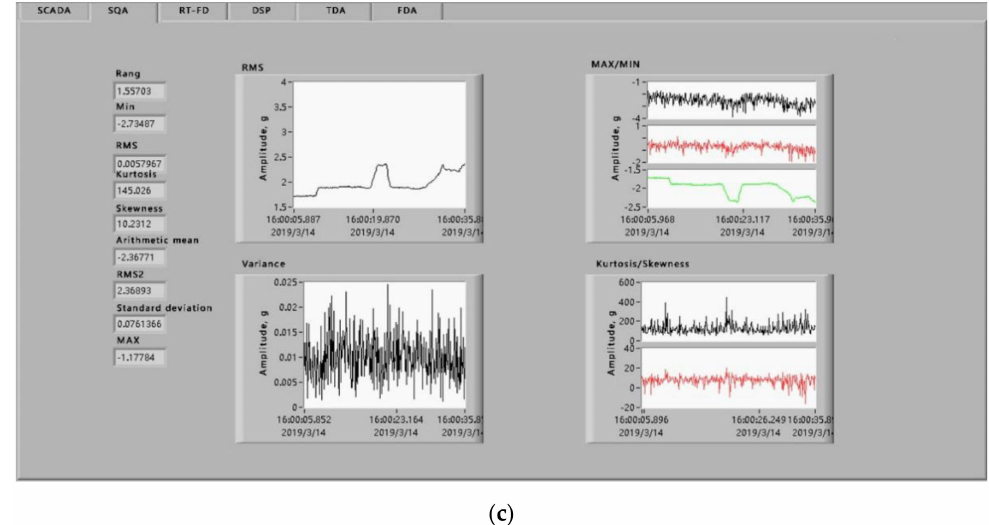
Figure 6. Operation interface ( a ) time domain, ( b ) frequency domain and ( c ) statistical